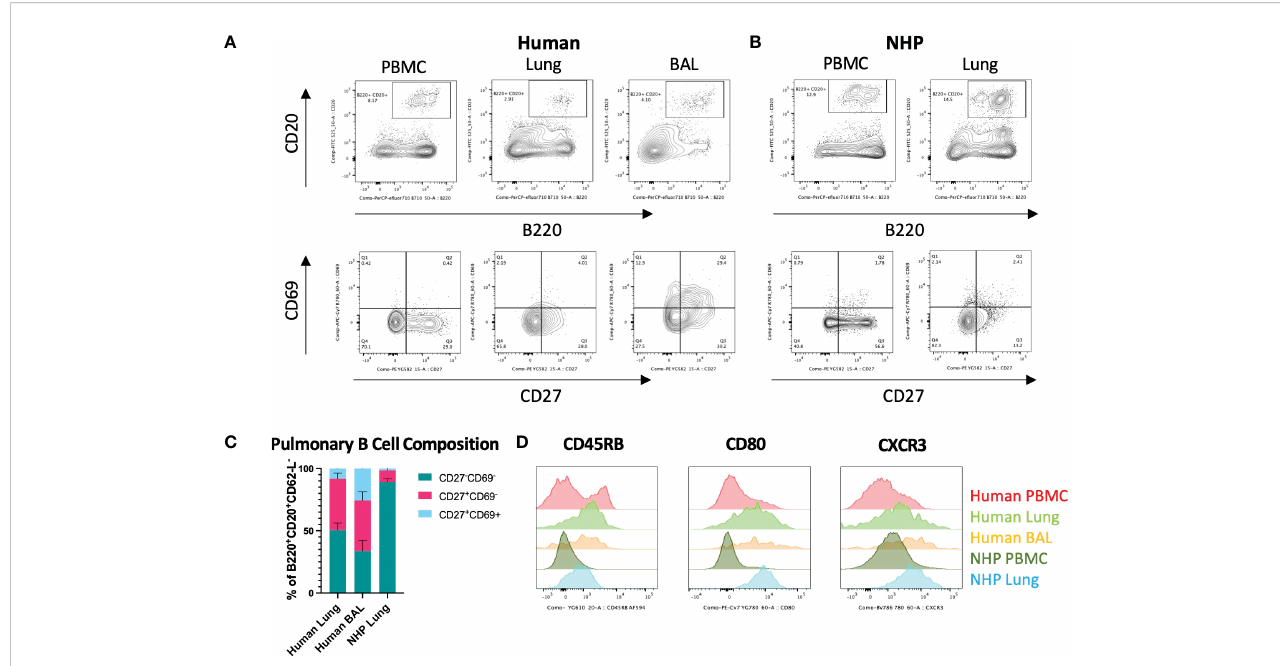
FIGURE 2 Characterisation of Human and NHP Pulmonary B RM . B RM were isolated from BAL and/or tissue digests and compared with peripheral B cells. (A) Identi fi cation of human pulmonary B RM . B RM (live, CD62L - , B220 + , CD20 + (lower panels)) were identi fi ed based on their expression of CD27 and CD69. (B) Identi fi cation of NHP pulmonary B RM . (C) Proportion of B RM in human and NHP lung. (D) Human and NHP B RM surface marker expression. Human and NHP samples were concatenated for analysis. Surface marker expression was compared to B cells isolated from peripheral blood (PBMC). Data represented as representative fl ow cytometry plots, compiled frequencies with mean ± SEM or histograms from human lungs (n=9), BAL (n=7) and NHP lung